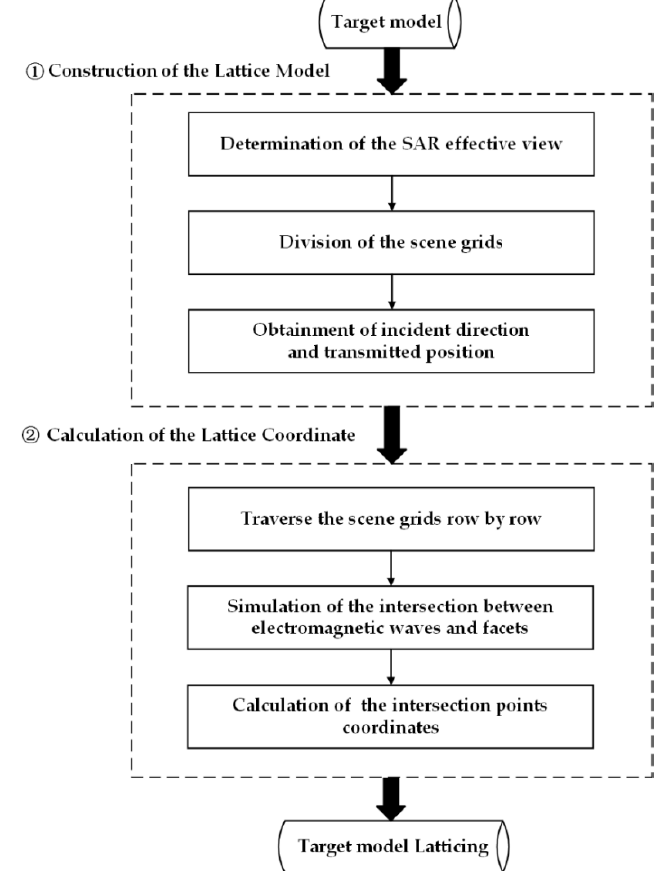
Figure 1. Flowchart of the SAR effective view algorithm.